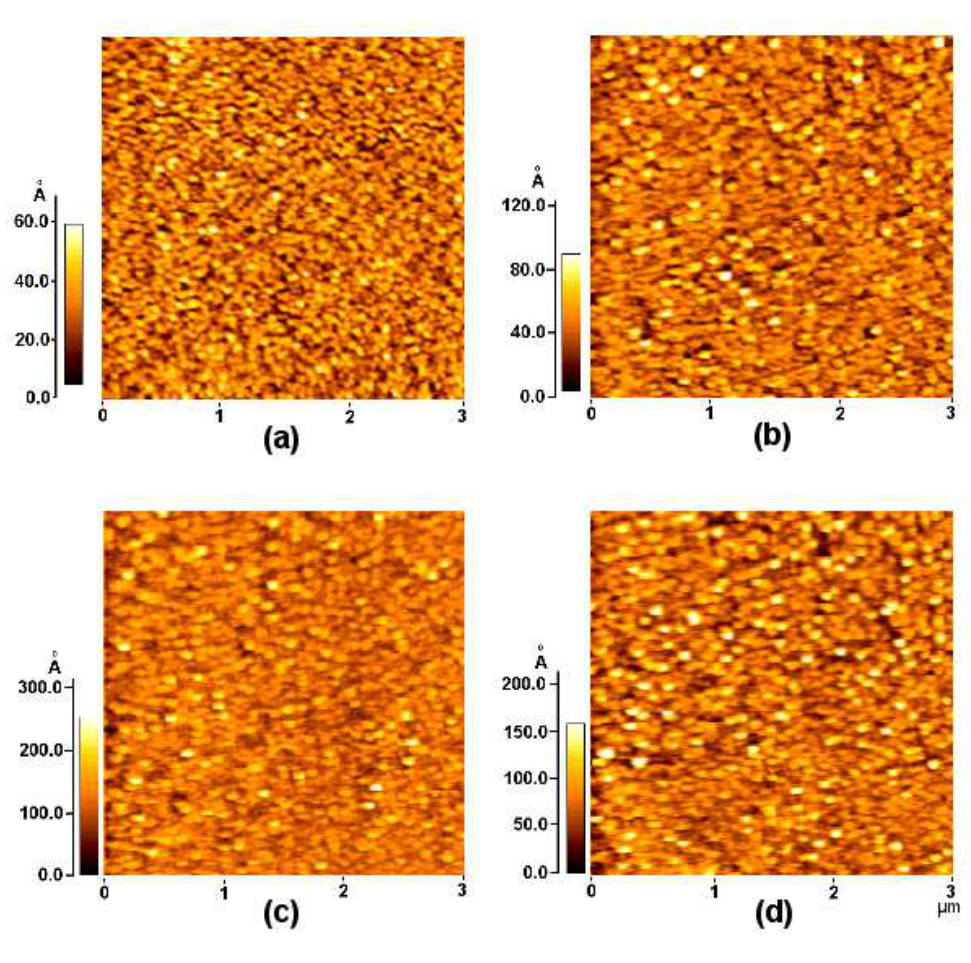
Figure 3. AFM images of phenylboronic acids modified Au surface. (a) Bare Au surface. (b) 1 - modified Au surface. (c) 2 -modified Au surface. (d) 3 -modified Au